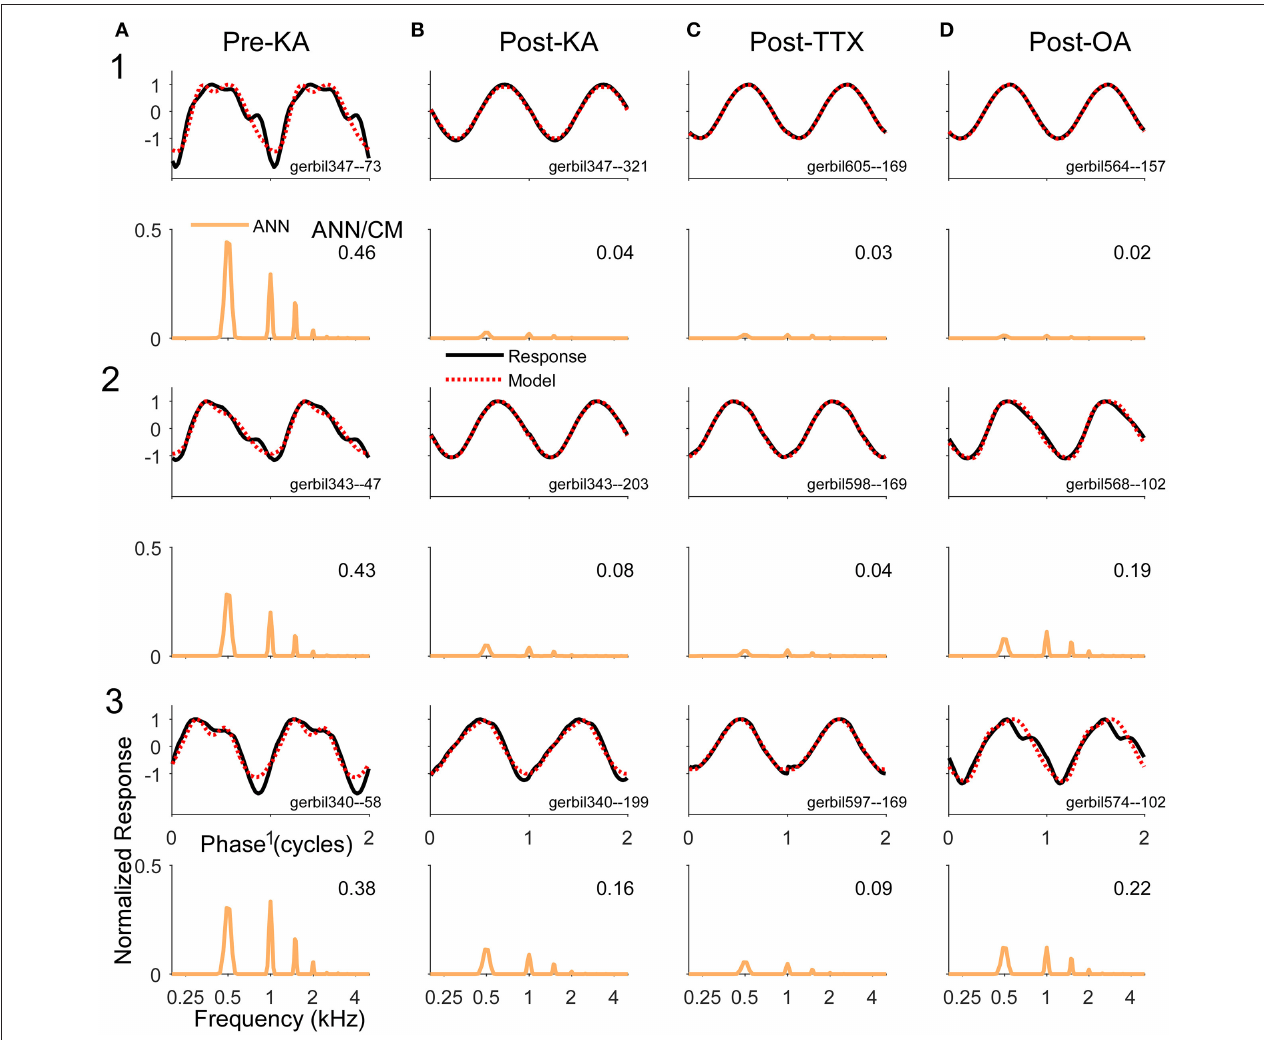
FIGURE 7 | Examples of waveforms and frequency spectra of ECochG signals in response to 500Hz tone burst at 50 dB SPL (A) . Three examples (1–3) recorded prior to KA. The waveforms shown strong distortions and in the ECochG and model waveforms (top panels) and the ANN has multiple harmonics in its spectra (bottom panels). Both sets of data were normalized by the maximum response. The numbers in the spectra represent the ANN/CM ratio. The CM is not shown. (B–D) Three examples each (1–3) recorded after KA, TTX, and OA, respectively. The waveforms show less distortion and smaller ANN/CM ratios, although the ANN is not completely removed in most cases. The cases (1–3) are in order of least to most remaining ANN for that drug. The Pre-Drug condition for TTX and OA are not shown, but were similar to that for